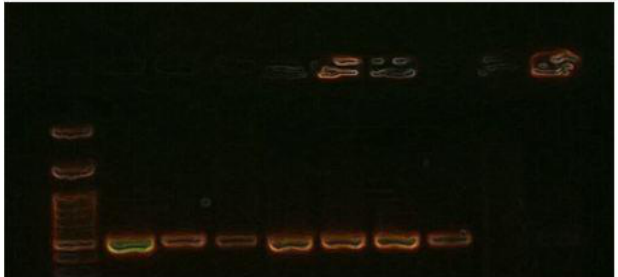
Fig.7: Agarose gel electrophoresis showing amplification of 290 bp fragment for tra T gene using specific primer. Lane 1: 1 kb Ladder, Lanes (2,3,4,5,6,7,8): positive Acinetobacter